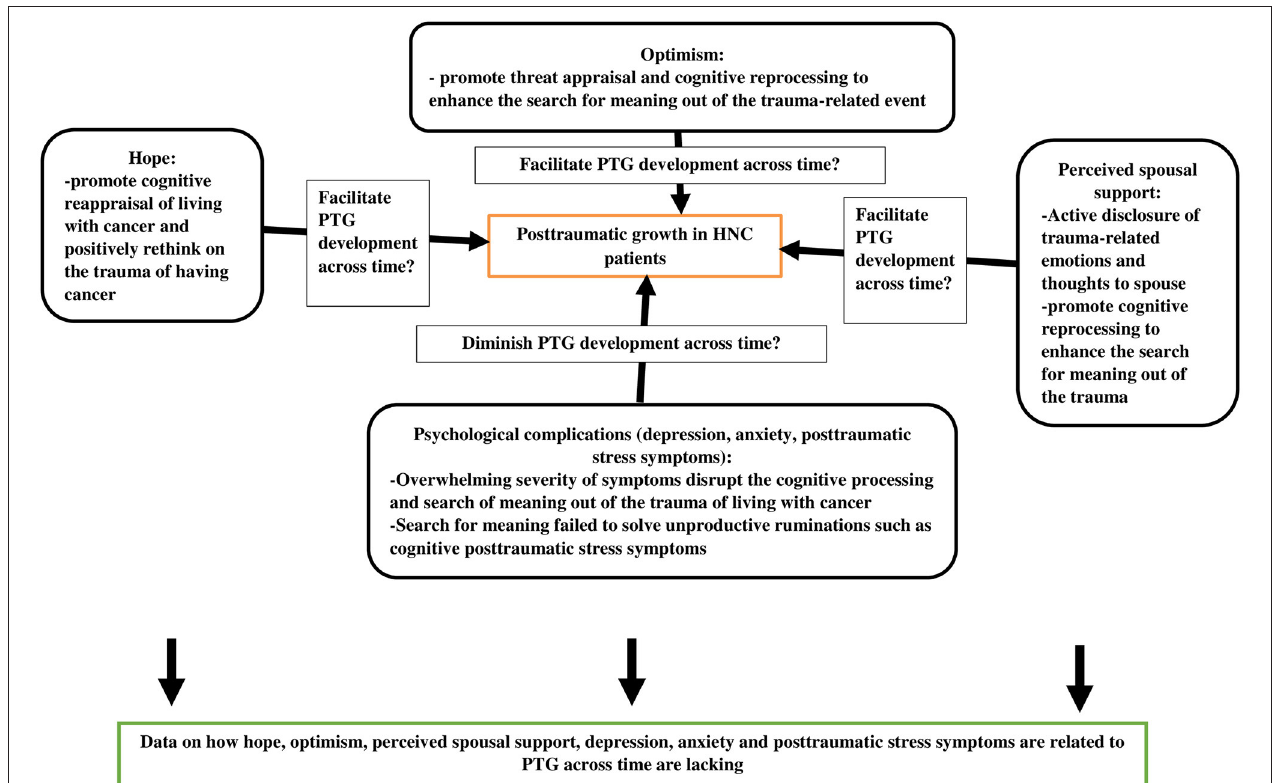
FIGURE 1 | The theoretical framework of the possible association between hope, optimism, perceived spousal support, psychological complications related to cancer and posttraumatic growth among cancer patients.